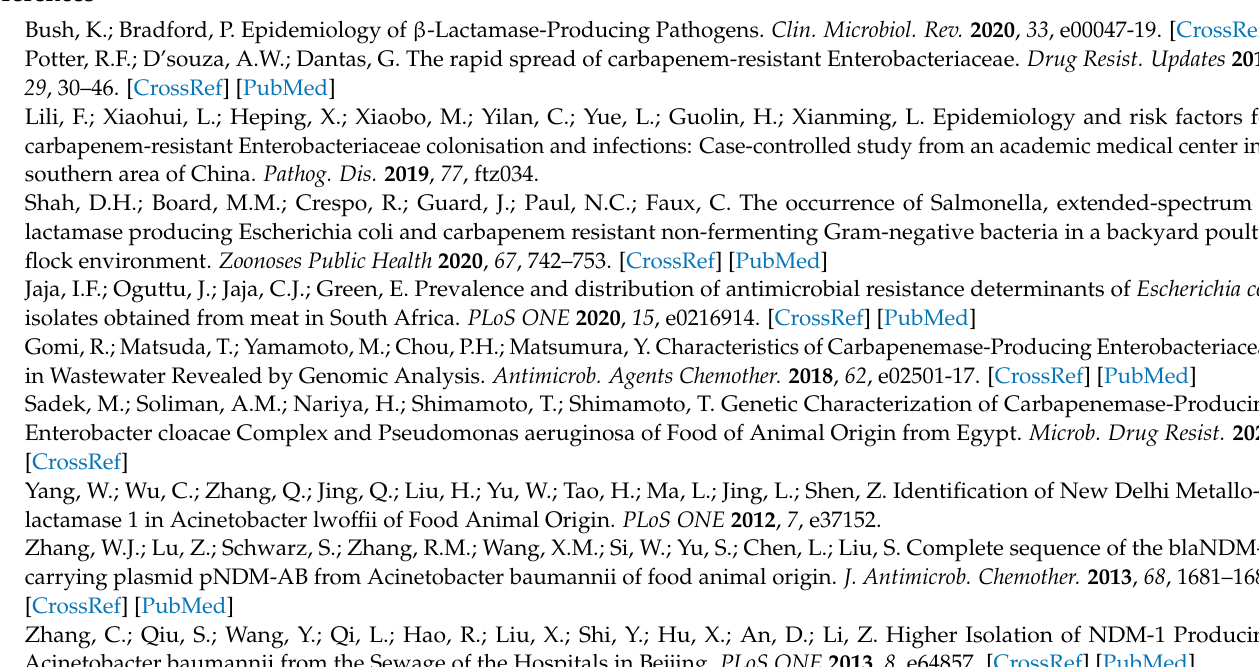
Table S3: Spearman’s rank correlation between the FFQ and